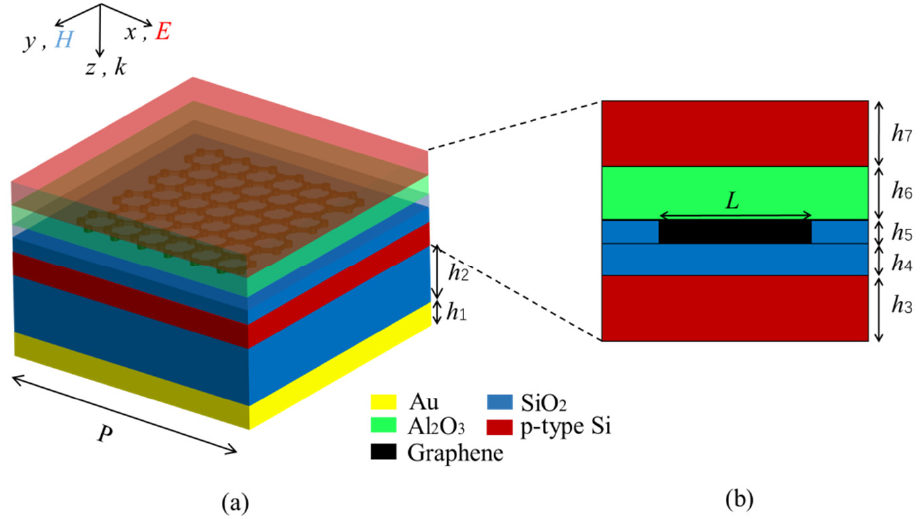
Figure 1. 3D schematic ( a ) and side view of floating gate ( b ). The geometrical dimensions are P = 13 µm, L = 7.2 µm, h 1 = 0.2 µm, h 2 = 8.4 µm, h 3 = 0.2 µm, h 4 = 10 nm, h 5 = 1 nm, h 6 = 20 nm, h 7 = 0.2 µm. The values of h 4 and h 6 are derived from reference [41].